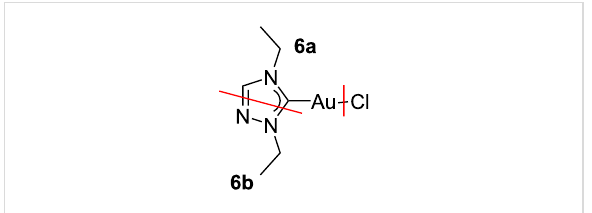
Figure 5: Possible fragmentations of (N,Et)AuCl ( 6 ), with the loss of Cl and a volatile fragment 6b, and the deposition of 6a .